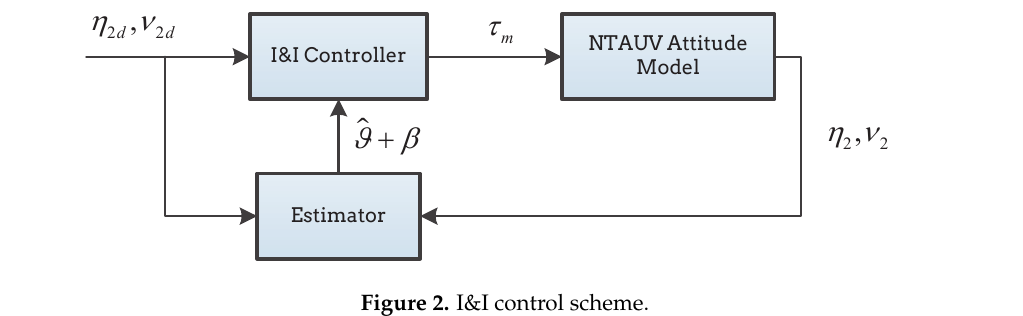
Figure 2. I&I control